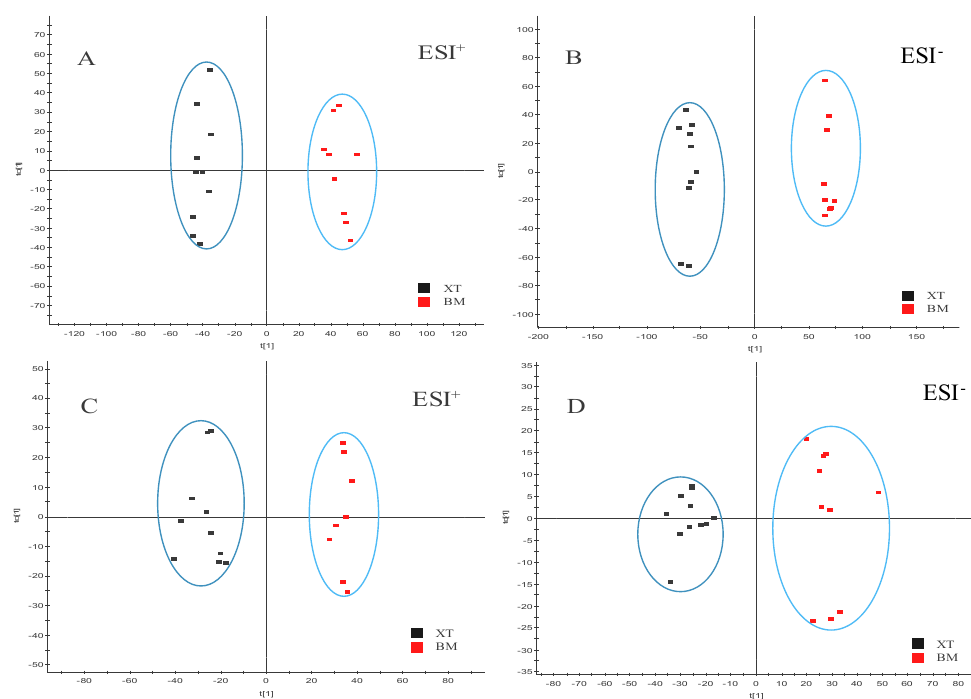
Figure 4. OPLS-DA score plots of urine metabolic profiling ( A , B ) and blood metabolic profiling ( C , D ) of BM and XT.